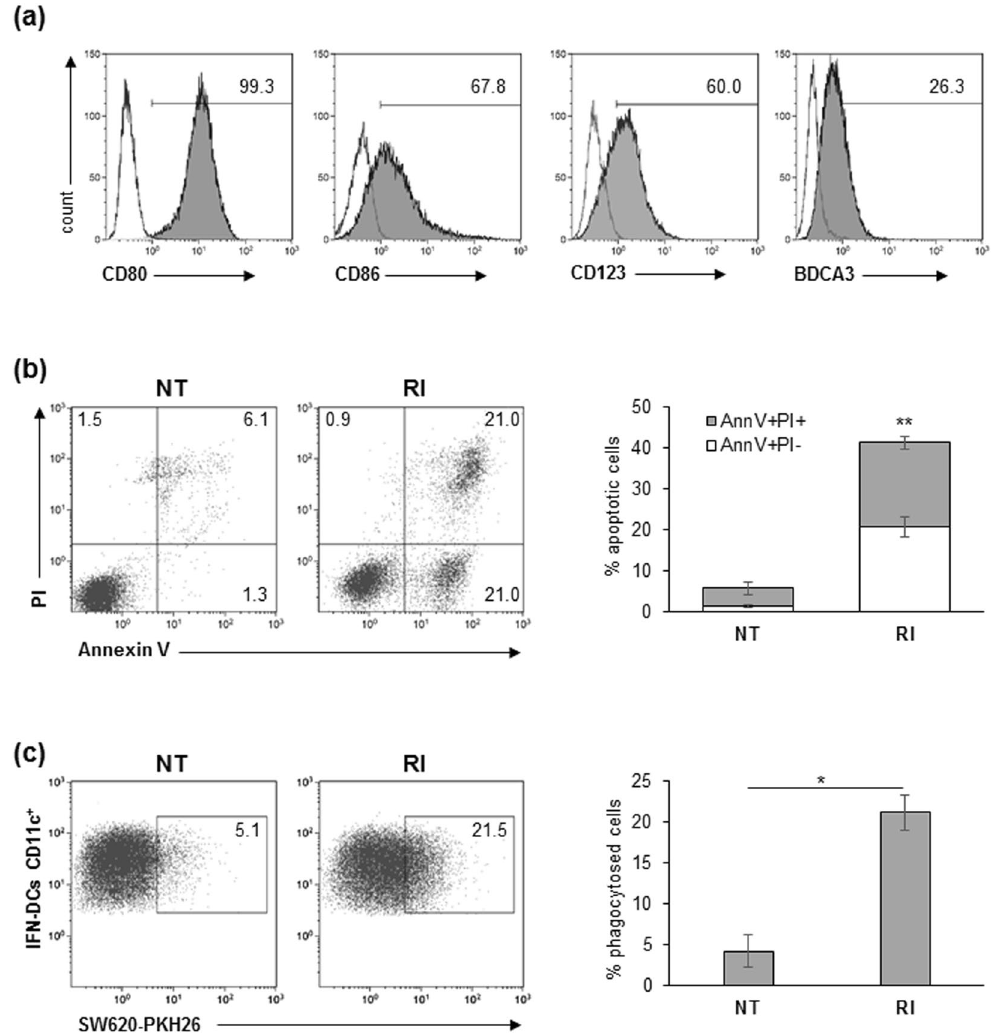
Figure 1. IFN-DCs efficiently phagocytose RI-treated SW620 cells. ( a ) Human monocyte-derived DCs generated in the presence of both IFN- α 2b and GM-CSF were analysed by flow cytometry for the expression of maturation and differentiation markers. Percentages of positive cells (filled histograms) are shown; empty histograms represent isotype controls. Data are representative of three independent experiments. ( b ) Analysis of apoptosis of SW620 cells induced by 48 h-treatment with the combination of romidepsin and IFN- α 2b (RI), as compared to untreated (NT) cancer cells. In the flow plots, early apoptotic cells (Annexin V + /PI − ), late apoptotic cells (Annexin V + /PI + ), necrotic cells (Annexin V − /PI + ) and vital cells (Annexin V − /PI − ) can be distinguished. One representative experiment out of four independent experiments is shown (left panel). In the right panel, percentages ± s.d. of AnnV + /PI − and AnnV + /PI + cells are shown (N = 4). ( c ) Flow cytometry analysis of phagocytosis of NT or RI-treated PKH26-labeled SW620 cells by IFN-DCs after a 4 h co-culture. IFN-DCs were stained with anti-CD11c mAb. One representative experiment (left panel) and the mean percentage ± s.d. of phagocytosed cells (right panel) are shown (N =